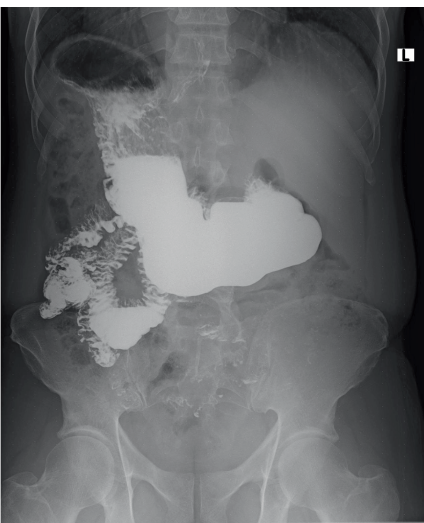
Figure 6: Barium sulphate meal spot radiograph. This shows the stomach on the right under the right hemidiaphragm, a definite air- barium level under the right hemidiaphragm with the heavier barium inferiorly and gastric air